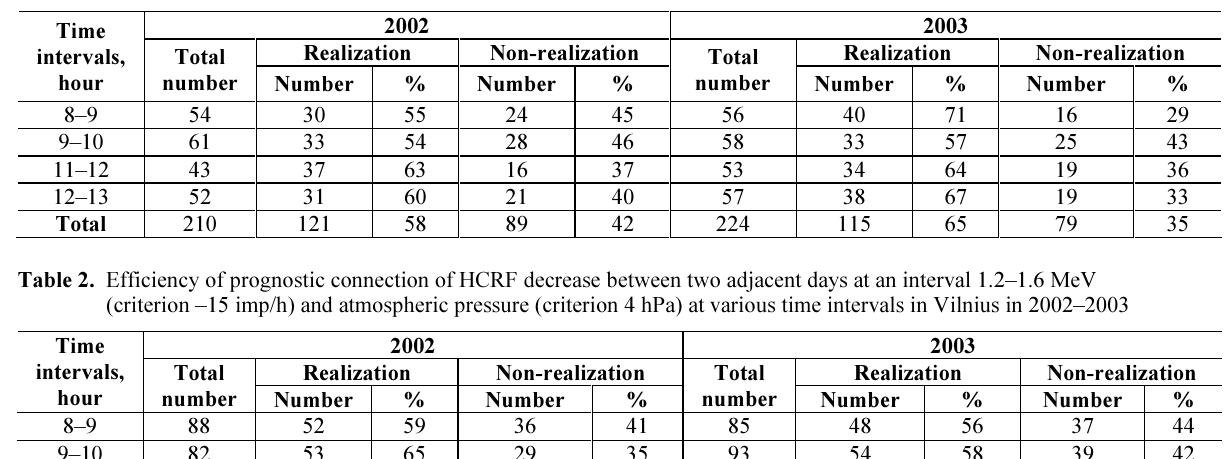
Table 1. Efficiency of prognostic connection between HCRF decrease (deviation from monthly average value) at an energy interval